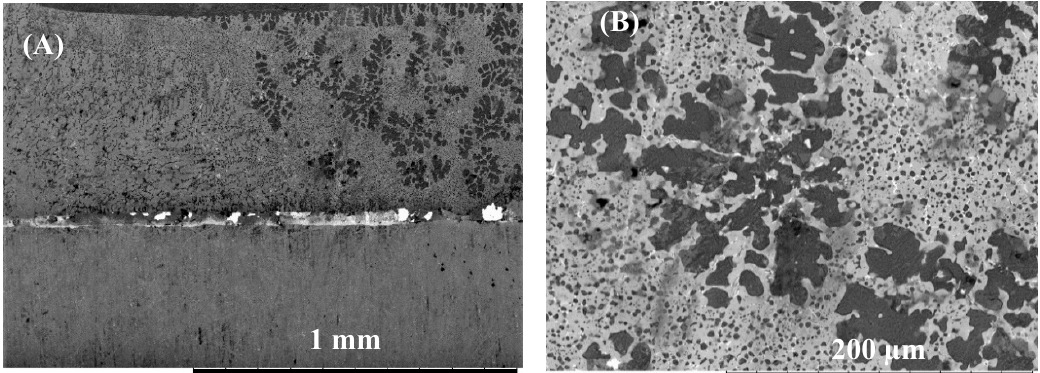
Figure 9. ( A ) SEM micrograph of Mg/Al bonded for 5 min using Cu/Al 2 O 3 interlayer. ( B ) Bond interface.